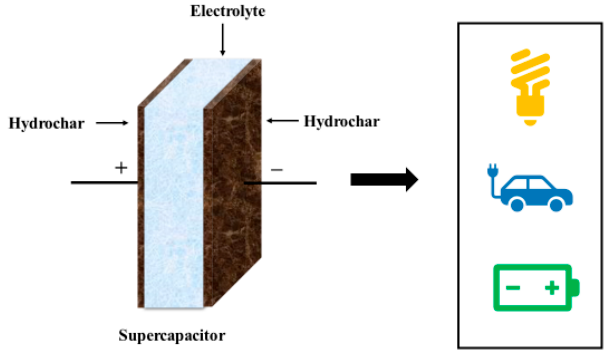
Figure 4. Hydrochar as supercapacitor.